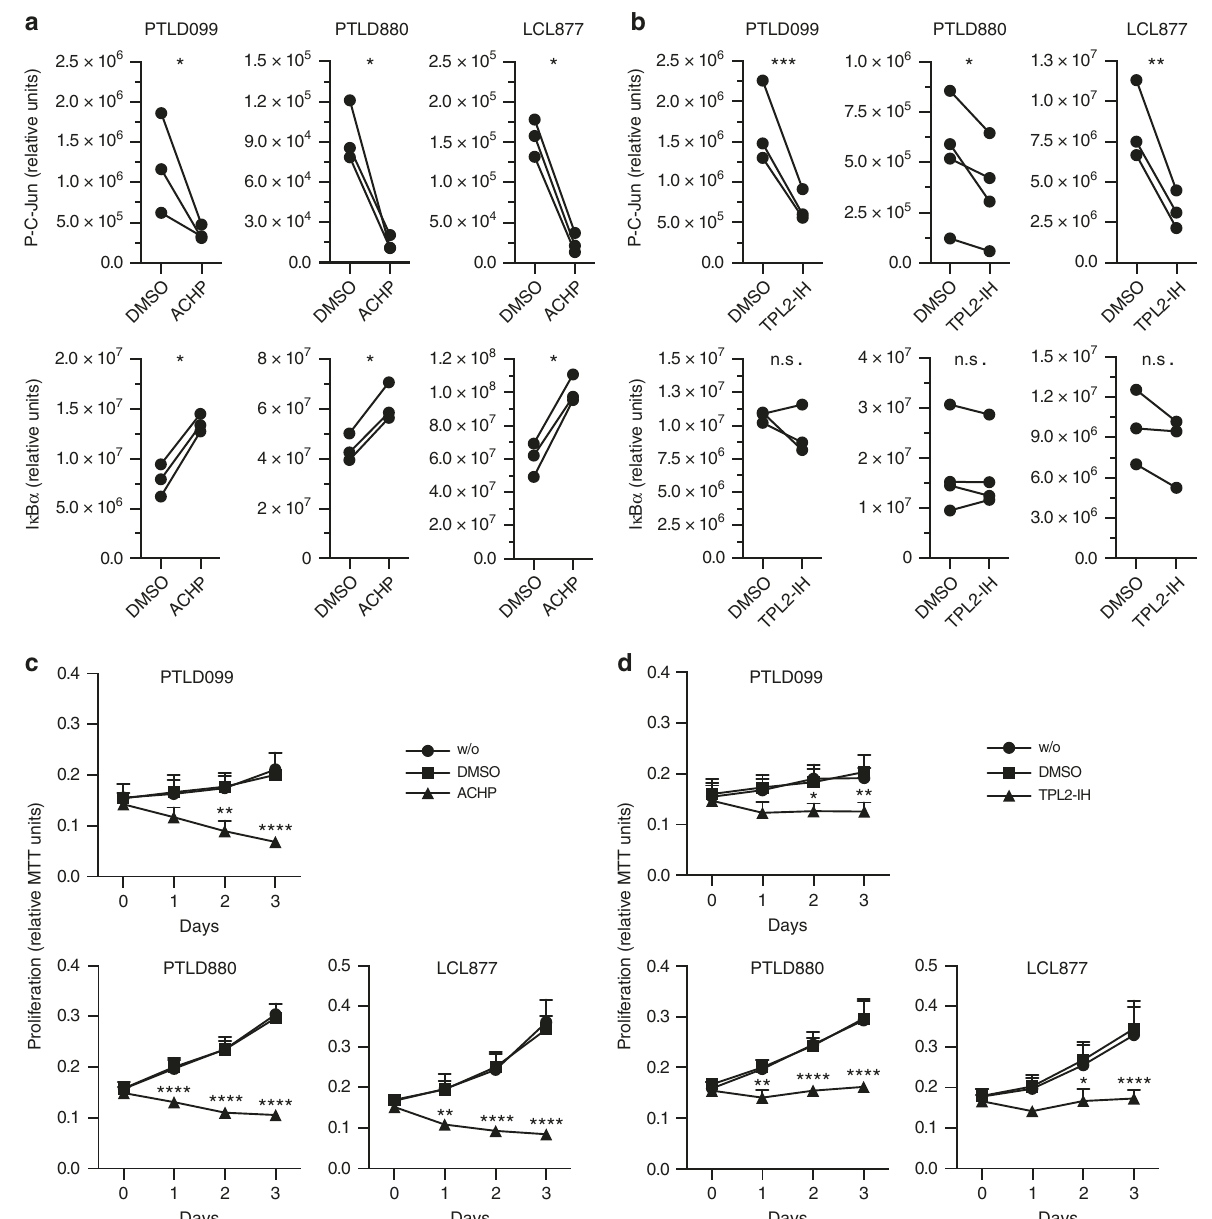
Fig. 8 The IKK2-TPL2-JNK pathway mediates proliferation of LMP1-expressing PTLD tumor cells. a IKK inhibition blocks the JNK and canonical NF- κ B pathways in PTLD. PTLD099 and PTLD880 cells isolated from two different PTLD tumor biopsies and LCL877 corresponding to PTLD880 were incubated with DMSO or 10 µ M of ACHP for 3h. Chemiluminescence signals of immunoblots using the indicated antibodies were quanti fi ed directly. Paired signals standardized to total protein levels of three biological replicates are shown. Chemiluminescence values ( y -axes) are relative and do not allow for direct comparison between graphs. b TPL2 mediates JNK, but not canonical NF- κ B, activity in PTLD cells. The experiment was performed as described in a , except that 10 µ M of TPL2 inhibitor TC-S7006 was used. Paired signals standardized to total protein levels of three (PTLD099, LCL877) or four (PTLD880) biological replicates are shown. c ACHP blocks proliferation of PTLD tumor cells. Cells were incubated with or without DMSO, or in the presence of 10 µ M of ACHP. At the indicated times, MTT assays were performed. d TPL2 is required for PTLD proliferation. MTT assays in the presence of 10 µ M of TPL2-IH. c , d The data are mean values±SD of three biological replicates. a , b Statistical analysis was performed with the ratio paired T -test (two-tailed). c , d Statistical analysis was performed with two-way ANOVA at alpha 0.05. a – d p -values: * p ≤ 0.05, ** p ≤ 0.01, *** p ≤ 0.001, **** p ≤ 0.0001, n.s. not signi fi